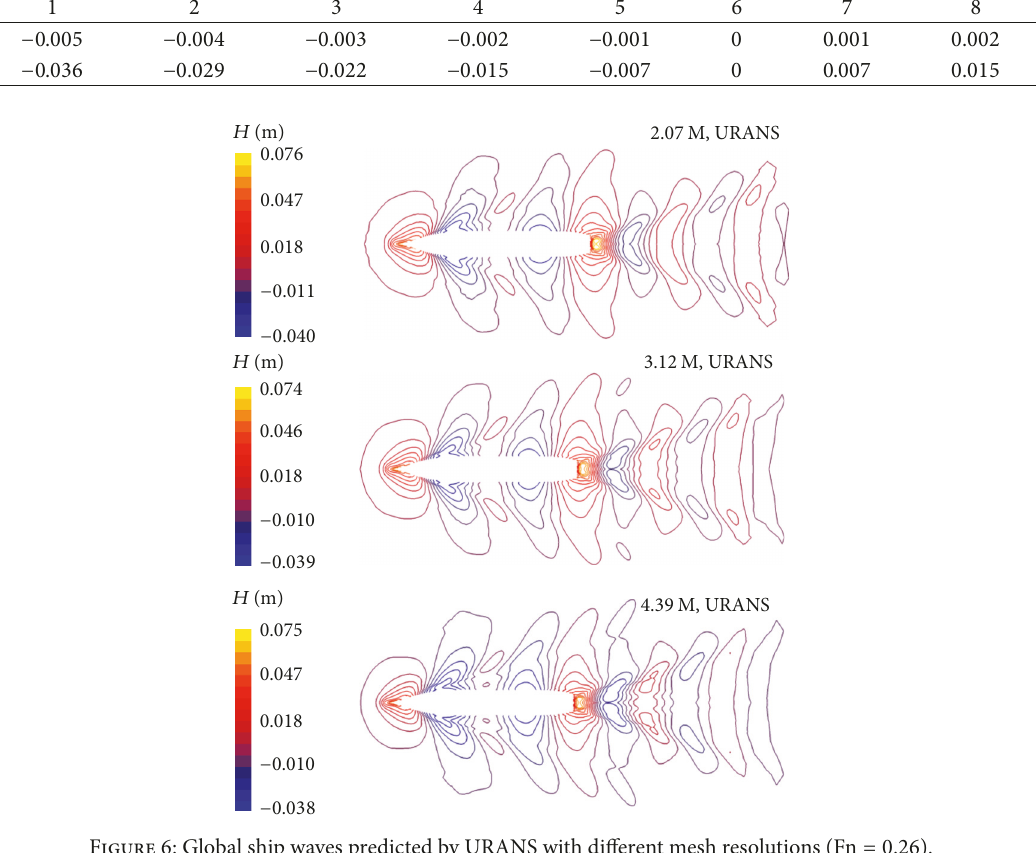
Figure 6: Global ship waves predicted by URANS with different mesh resolutions (Fn = 0.26 ).